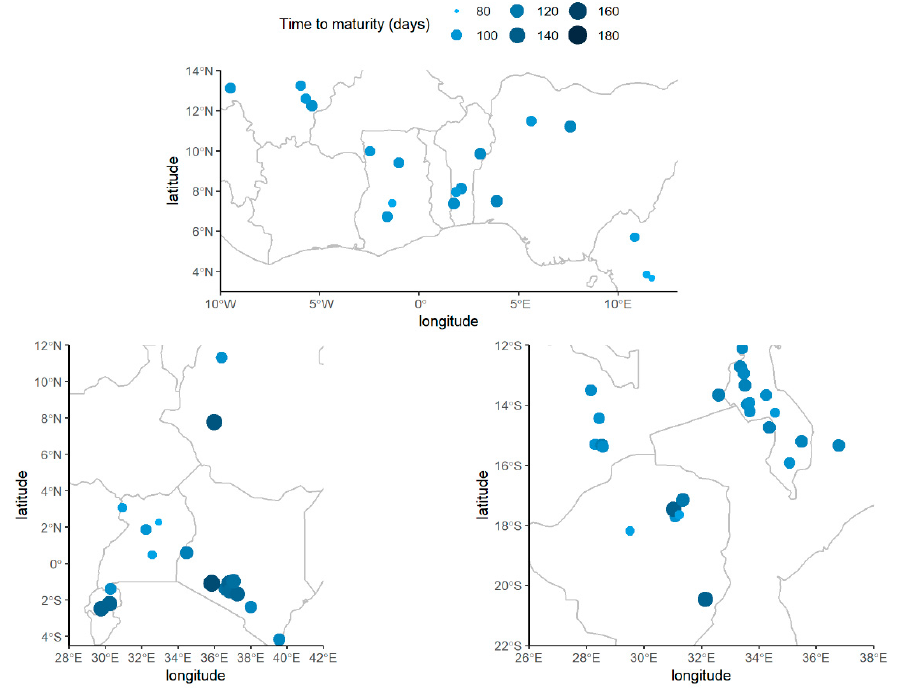
Figure 2. Countries, trial sites, and altitudes, considered for a soybean maturity prediction model adapted to soybeans grown in African conditions (Soybean Innovation Lab, Pan-African Variety Trials: SIL–PAT, 2015–2020).